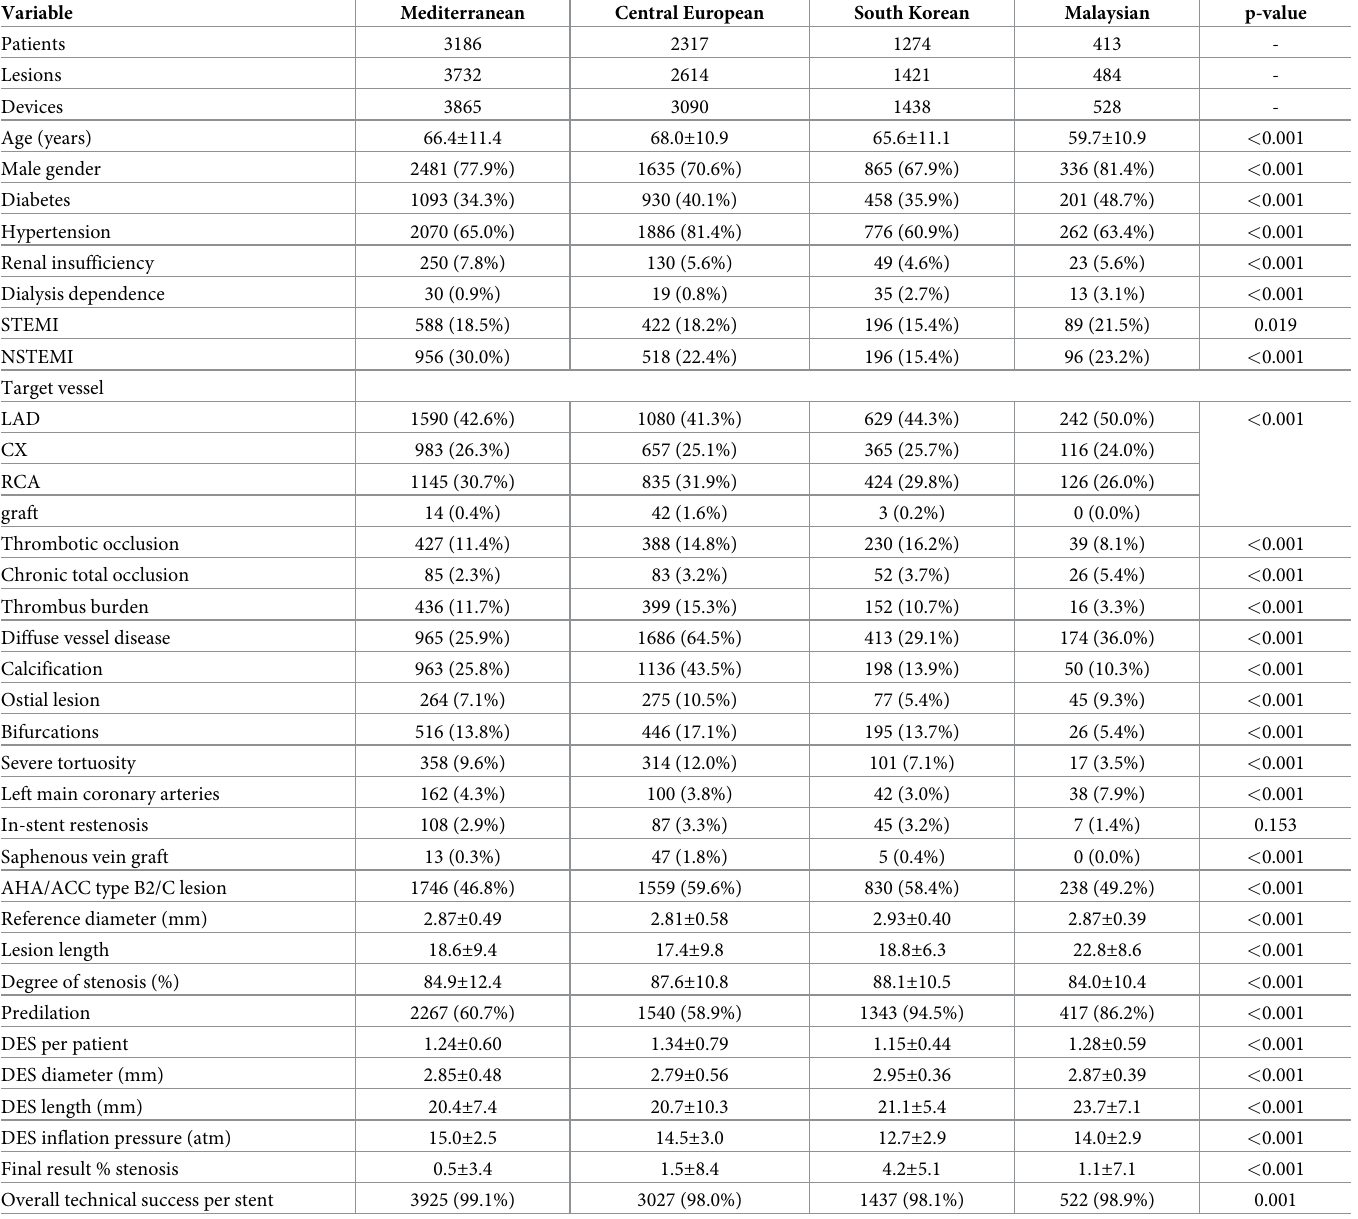
Table 1. Patient demographics, lesion and procedural